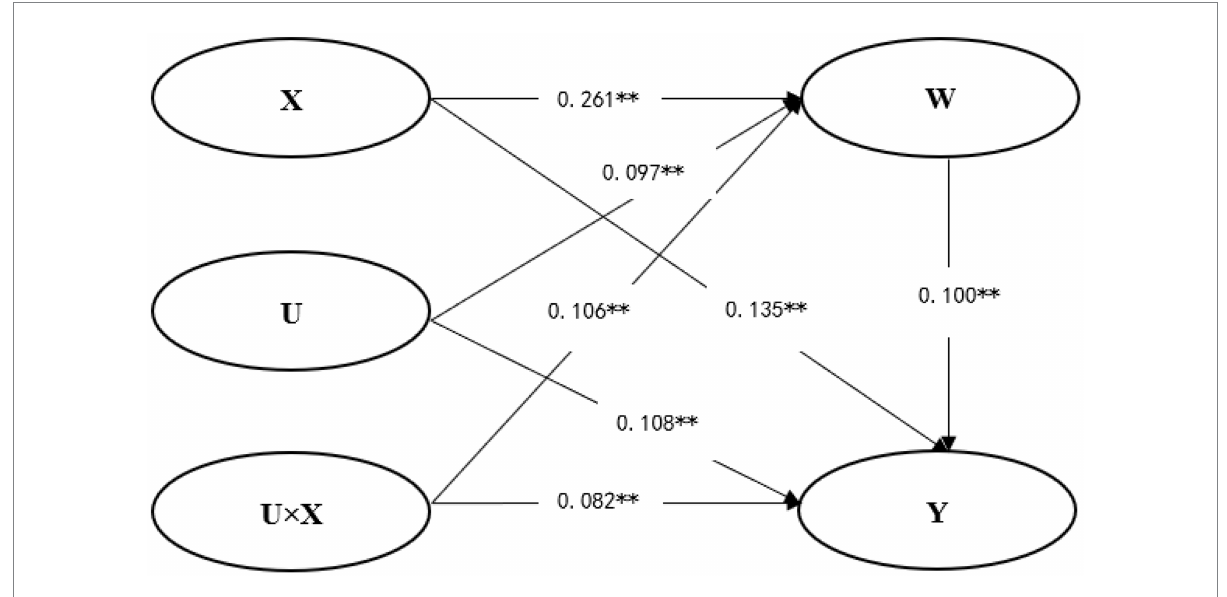
FIGURE 4 The mediated moderating model ( ** p